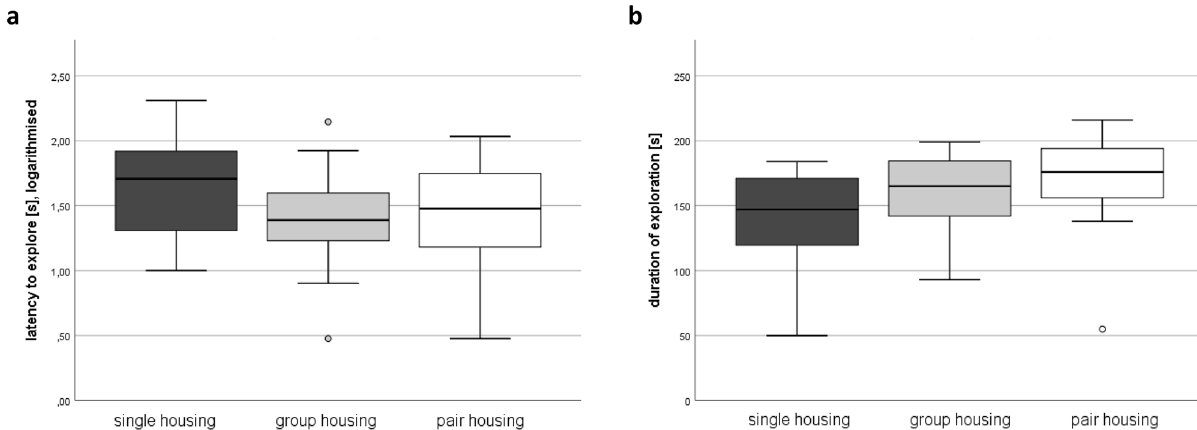
Figure 6. Anxiety-related behavior analyzed in the free exploratory paradigm. Latency to explore the gridded cage top ( a ) and total duration of exploration ( b ) in week 8. Data are presented as boxplot diagrams: the box represents the interquartile range (IQR), box edges are the 25th and 75th quartile. The whiskers represent values which are not greater than 1.5 × IQR. Dots are outliers with values between 1.5 ‒ 3.0 × IQR. Single housing: n = 16, group housing: n = 16, pair housing: n =